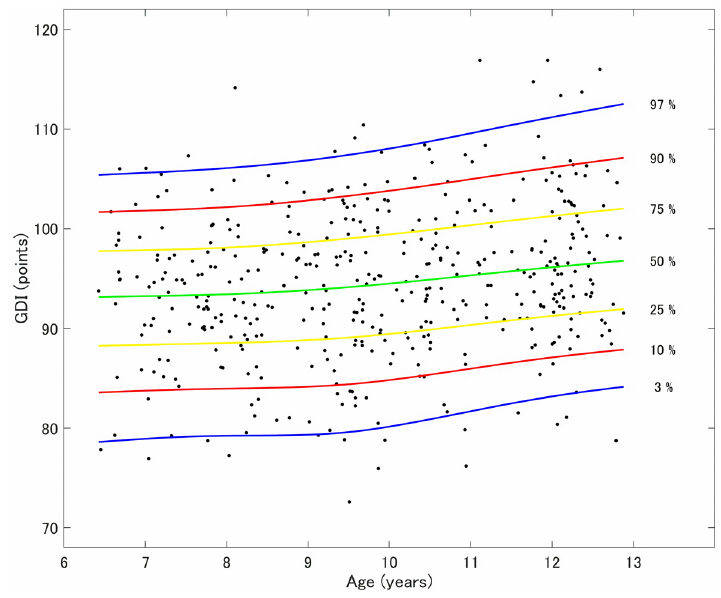
Figure 3. Centile chart of the Gait Deviation Index (GDI) standards by age . The developmental centile chart of the gait pattern was created using LMS Chartmaker, version 2.54 (Medical Research Council, London, UK). The 97th percentile represents the 97th value obtained after arranging the GDI data from the lowest to the highest values among 100 children of the same age; similarly, the 3rd percentile represents the third GDI value after arranging data from the lowest to the highest values. From top to bottom, the seven reference lines depict the 97th (blue), 90th (red), 75th (yellow), 50th (green), 25th (yellow),10th (red), and 3rd (blue) percentile curves. The color of each line corresponds to the number of standard deviations (SD) for each percentile shown (3rd percentile: − 1.88 SD; 10th percentile: − 1.28SD; 25th percentile: − 0.67SD; 50th percentile: median; 75th percentile: 0.67SD; 90th percentile: 1.28SD; and 97th percentile: